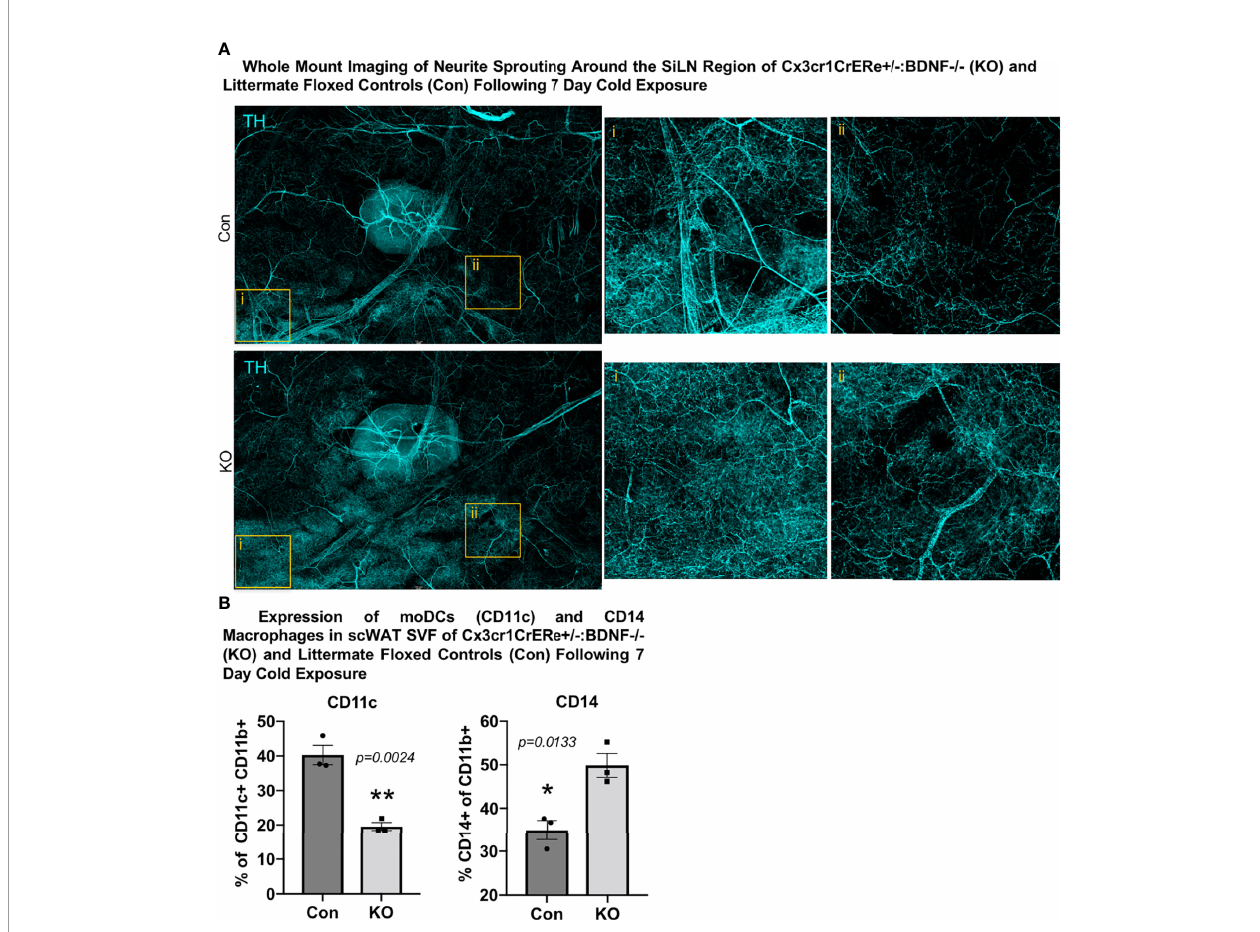
FIGURE 6 | Cx3crCreER1 +/- ::BDNF -/- (KO) mice exhibited increased neurite density around the SiLN, decreased expression of CD11c+ adipose SVF cells, and increased expression of CD14+ adipose SVF cells compared with littermate fl oxed controls (Con). (A) Regional imaging (around SiLN) of whole-mount scWAT depots described in Figure 5G , where neurite sprouting was most pronounced. Images are representative of N = 3 per group. (B) Adult (15 – 17 weeks old) male Cx3cr1CrERe +/- :BDNF -/- (KO) and their littermate Cx3cr1CrERe -/- ::BDNF fl / fl (Con) mice were cold-exposed (5°C) for 7 days. Stromal vascular fraction from bilateral inguinal scWAT depots was isolated, and fl ow cytometry was performed. Percentage change of CD11b+ CD11c+ cells and CD11b+ CD14+ cells in Con and KO mice. Data were analyzed by two-tailed Student ’ s t -test; N = 3 per group. All error bars are SEMs. * p < 0.05, ** p <